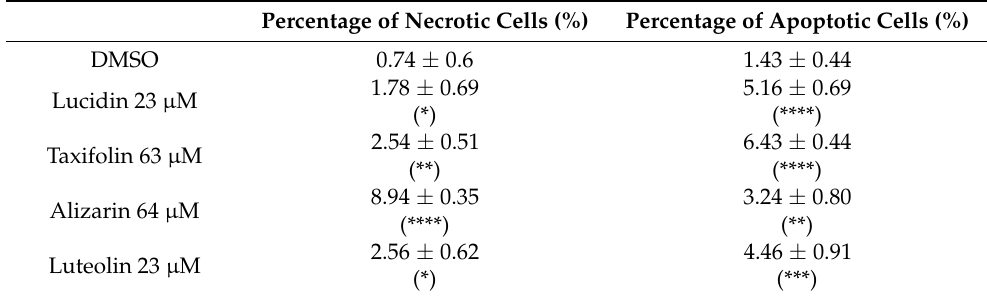
Table 3. Percentage of necrotic and apoptotic cells (%) with data presented as mean ± SD, n = 6. The analysis was performed by the t -Student test (statistical significance in comparison to DMSO-treated cells as p -values * < 0.05, ** < 0.01, *** < 0.001, **** <